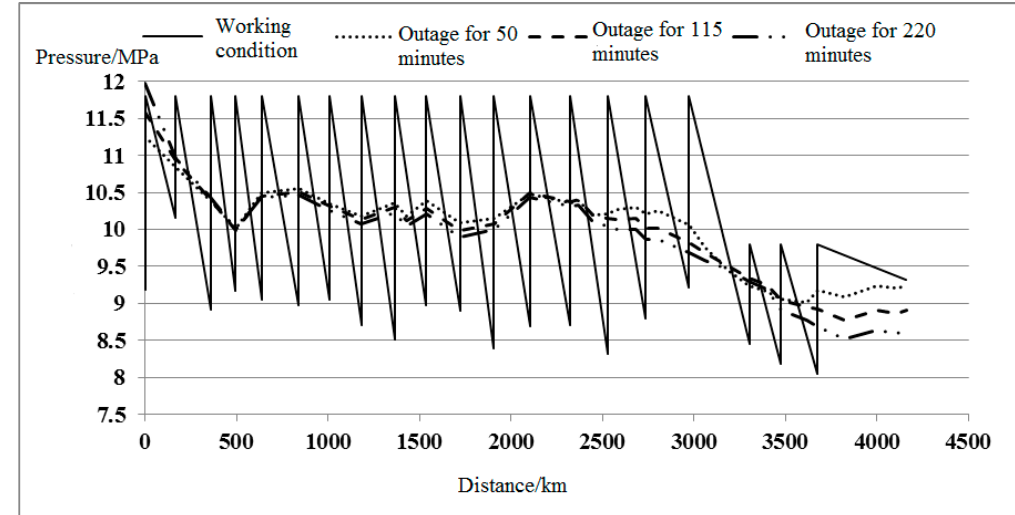
Figure 4. Pressure changes along the pipeline after the compressors are shut down. (2) Number of compressors in the outage. The outage probability for the single compressor unit was 7.06%. The outage probabil- ity and time calculated by the binomial distribution method and Monte Carlo method can be seen in Table 4. Table 4. Outage probability and